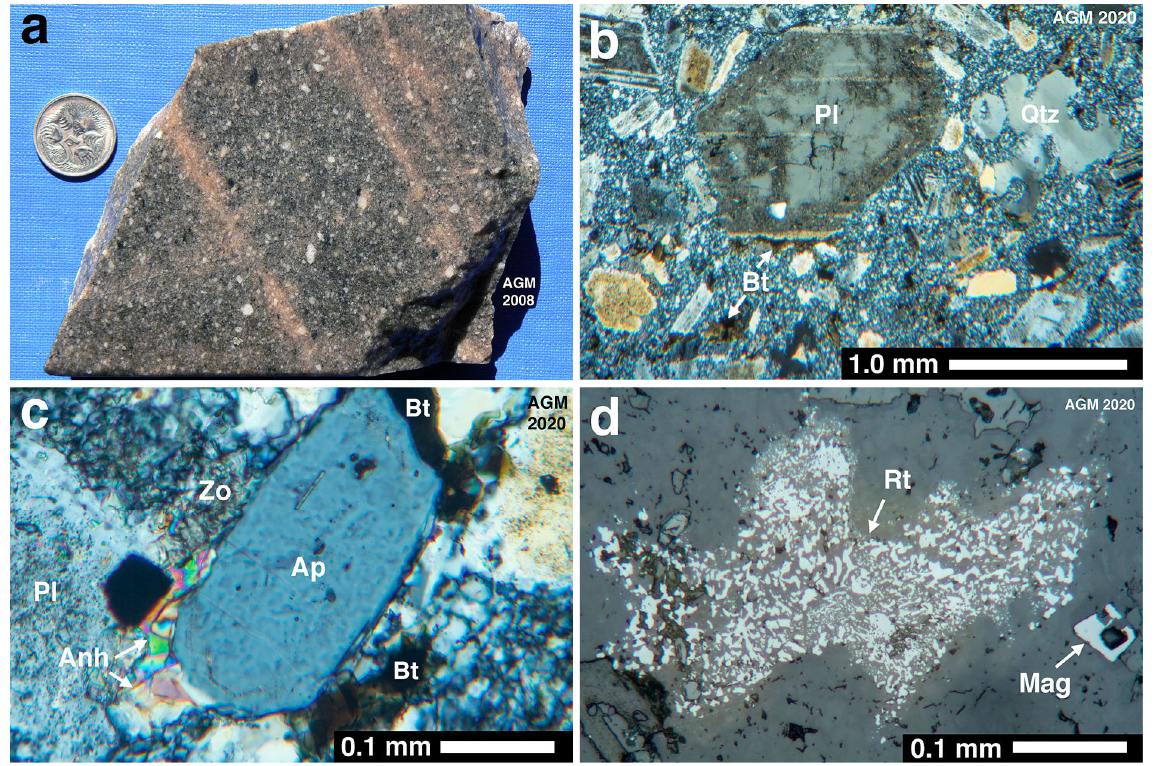
Figure 5. Photographs and photomicrographs of the East Porphyry, sample HB-4. ( a ) Quartz-plagioclase porphyry: white plagioclase glomerocrysts, quartz phenocrysts, and plagioclase laths in a microcrystalline groundmass. Brown biotite (7%) is disseminated and on fractures, and in biotite-calcite-phengite aggregates (after hornblende?). Red selvages of dispersed hematite surround quartz veinlets. The coin is 19 mm across. ( b ) Plagioclase (Pl) and embayed quartz (Qtz) phenocrysts are rimmed by biotite (Bt), calcite and zoisite, which also form aggregates in the groundmass. Crossed polarized light. ( c ) Apatite (Ap) and plagioclase phenocrysts (Pl) rimmed by oxidized biotite (Bt), anhydrite (Anh), zoisite (Zo), and opaque pyrite. Crossed polarized light. ( d ) Rutile (Rt) pseudomorphous after Ti-rich hornblende or pyroxene adjacent to magnetite (Mag). Plane polarized light reflected in air.